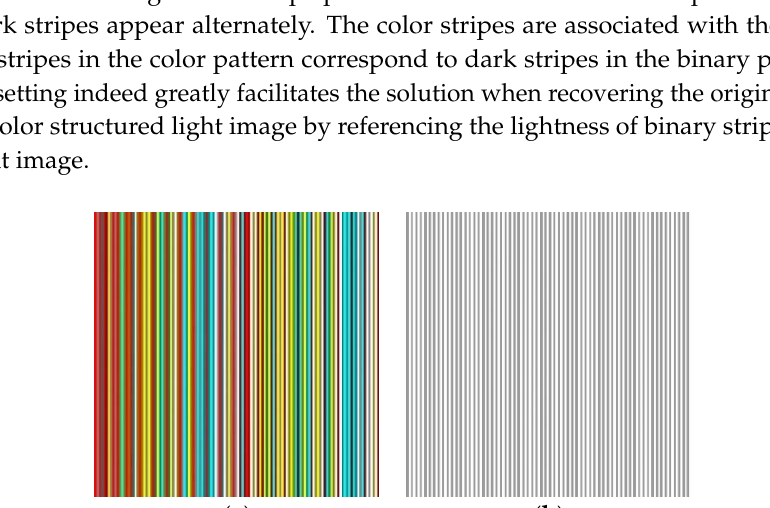
Figure 5. Pattern offset ∆ 𝑒𝑥𝑎𝑐𝑡 vs. detectable range [𝑎 𝑚𝑖𝑛 , 𝑎 𝑚𝑎𝑥 ] .